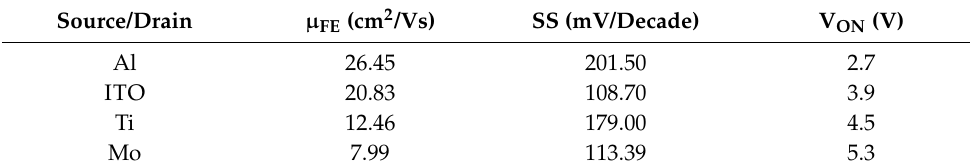
Figure 3. g m -V G plots measured for annealed TFTs with Al, ITO, Ti, and Mo S/D electrodes. Table 1. Electrical parameters of ITO TFTs, including µ FE , SS, and V ON .